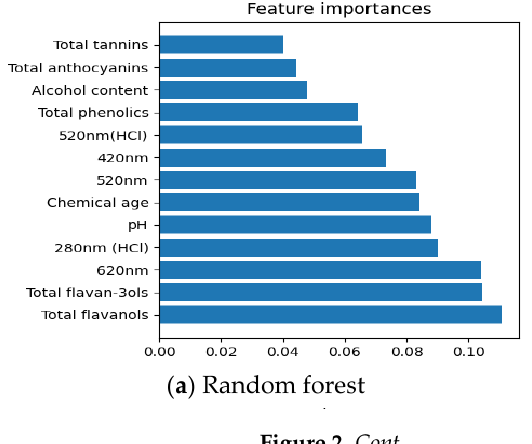
( d ) Extreme gradient boost Figure 2. Features selection of 13 chemical data using Random Forest (RF), Extra trees classifier, Gradient boosting classifier, and Extreme gradient boost (XGBOOST) in regions of origin. ( a – d ) display the important chemical parameters in regions of origin that areselected by Random Forest, Extra trees classifier, Gradient boosting classifier and Extreme gradient boost, respectively. Feature selecting methods, including Random forest, Extra trees classifier, Gradient boosting classifier, and Extreme gradient boost, are utilized to define the association between 13 chemical data and the locations of origin of New Zealand Pinot noir wines in Figure 2. Even though some of the results in Figure 2a – d differ, it is still possible to con- clude that total flavan-3-ols and A620 nm were the most important chemical parameters among 13 chemical data for characterizing the regions of origin of New Zealand Pinot noir wines except Figure 2a. Previously, Sun (2015) discovered that flavan-3-ol profiles might be utilized to distinguish the regional origin of red wines [47]. In addition, the blue component (A620 nm) is attributed to free anthocyanins in the chinonic form or interac- tions between tannins and anthocyanins, and total anthocyanins may also be altered by climate conditions specific to an area [24,48].